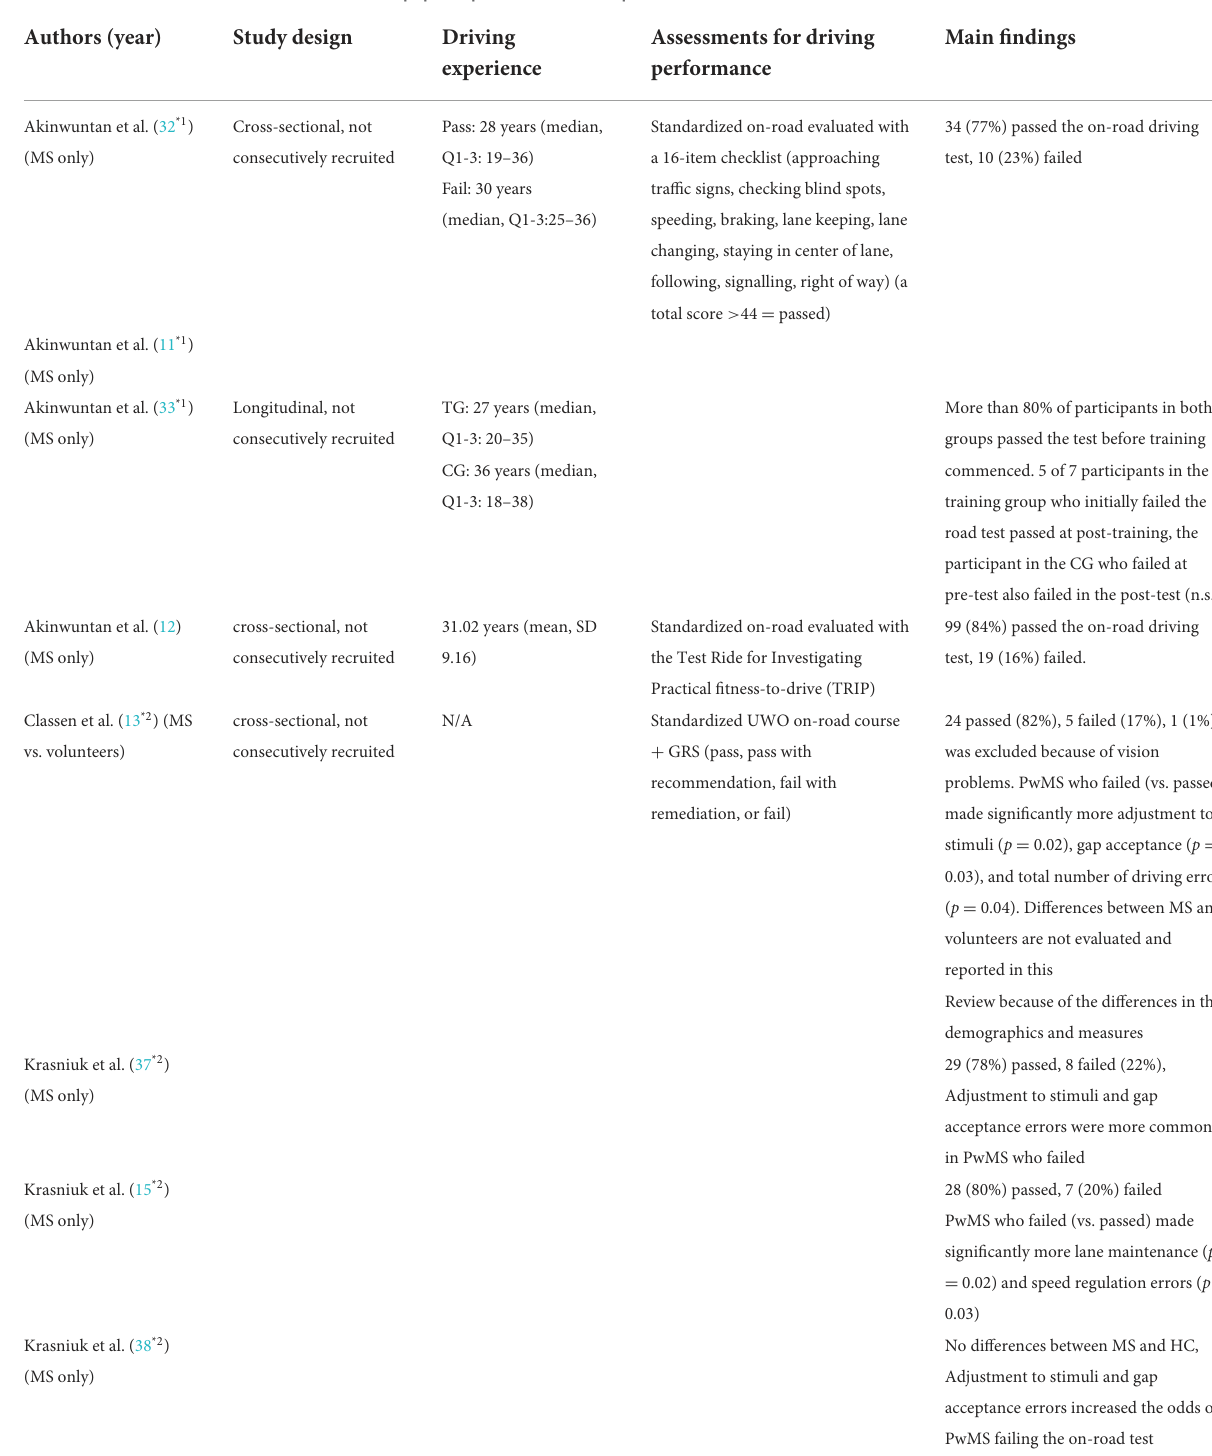
TABLE 1 Main results in on-road studies (x n = paper report the same